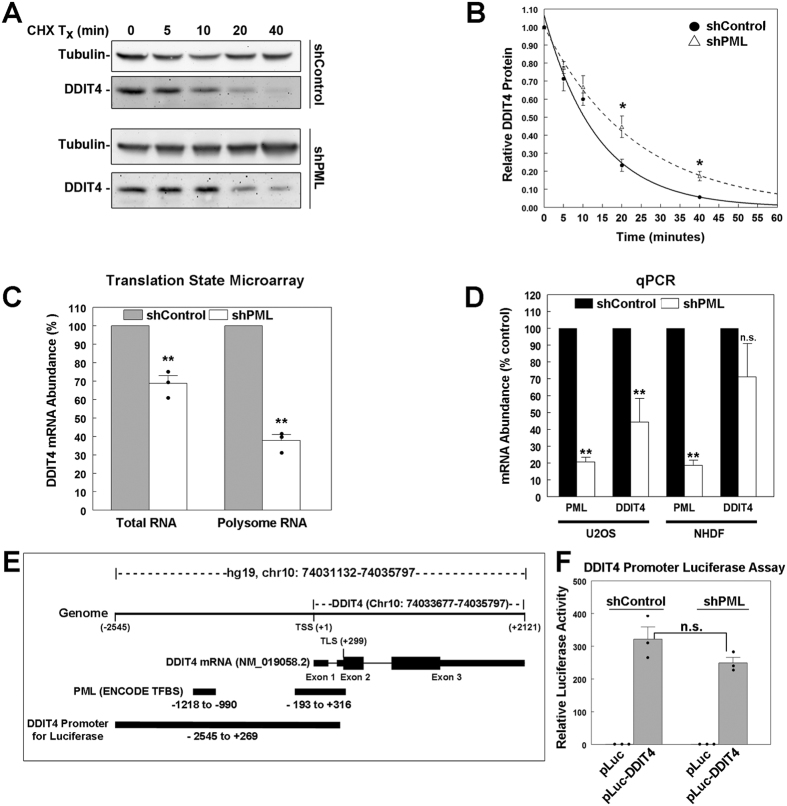
PML loss inhibits DDIT4 gene expression.(A) Western blot analysis of DDIT4 expression in shControl and shPML U2OS cells treated with cycloheximide (CHX) for the indicated times. Representative blots from 3 independent experiments were chosen to best illustrate the differences in protein stability as quantified in (B). Unprocessed full-length blots for this figure are presented in Supplementary Figure 4. (B) Quantification of DDIT4 protein levels over time in cells treated as in A. For each cell line, DDIT4 protein densitometry values were normalized to tubulin and are reported relative to the t0 time point (n = 3). (C) Quantification of DDIT4 total RNA and polysome-associated RNA from shControl and shPML U2OS cells (n = 3). (D) QRT-PCR of DDIT4 and PML mRNA abundance in U2OS (n = 5) and NHDF (n = 7) for shPML and shControl cells. (E) DDIT4 genomic region (hg19, chr10: 74031132–74035797). The DDIT4 transcript (NM_019058.2) contains three exons and an ORF spanning exons 2 and 3 (thick lines). PML binding sites are indicated (source: ENCODE, transcription factor binding site (TFBS) data), as well as the ~2.7 kb promoter region used in F is indicated. TSS = transcription start site, TLS = translation start site. (F) Quantification of luciferase expression in U2OS shControl and shPML cells (n = 3) driven by the DDIT4 promoter indicated in E. Values are the mean+/−SEM. p-values < 0.01 (**) or < 0.05 (*) and n.s. = not significant. Full-length blots for this figure are presented in Supplementary Figure 4.